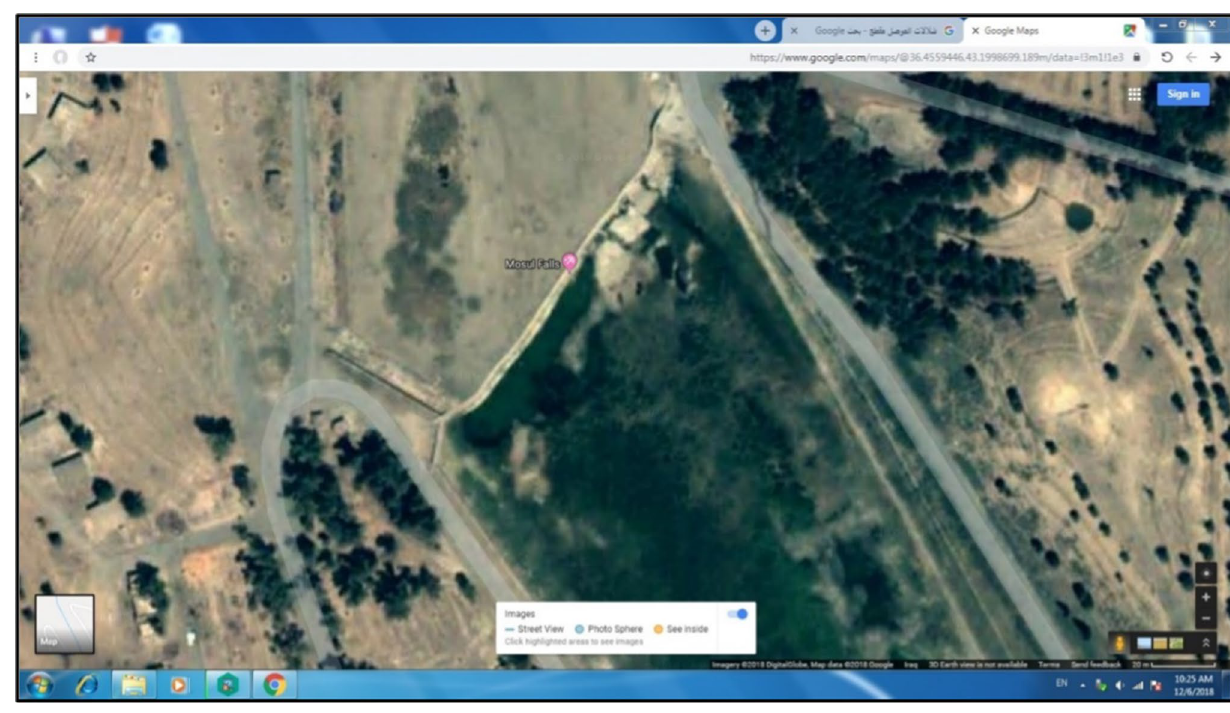
Fig. 3 Measuring the total length of the stepped weir using Google Maps